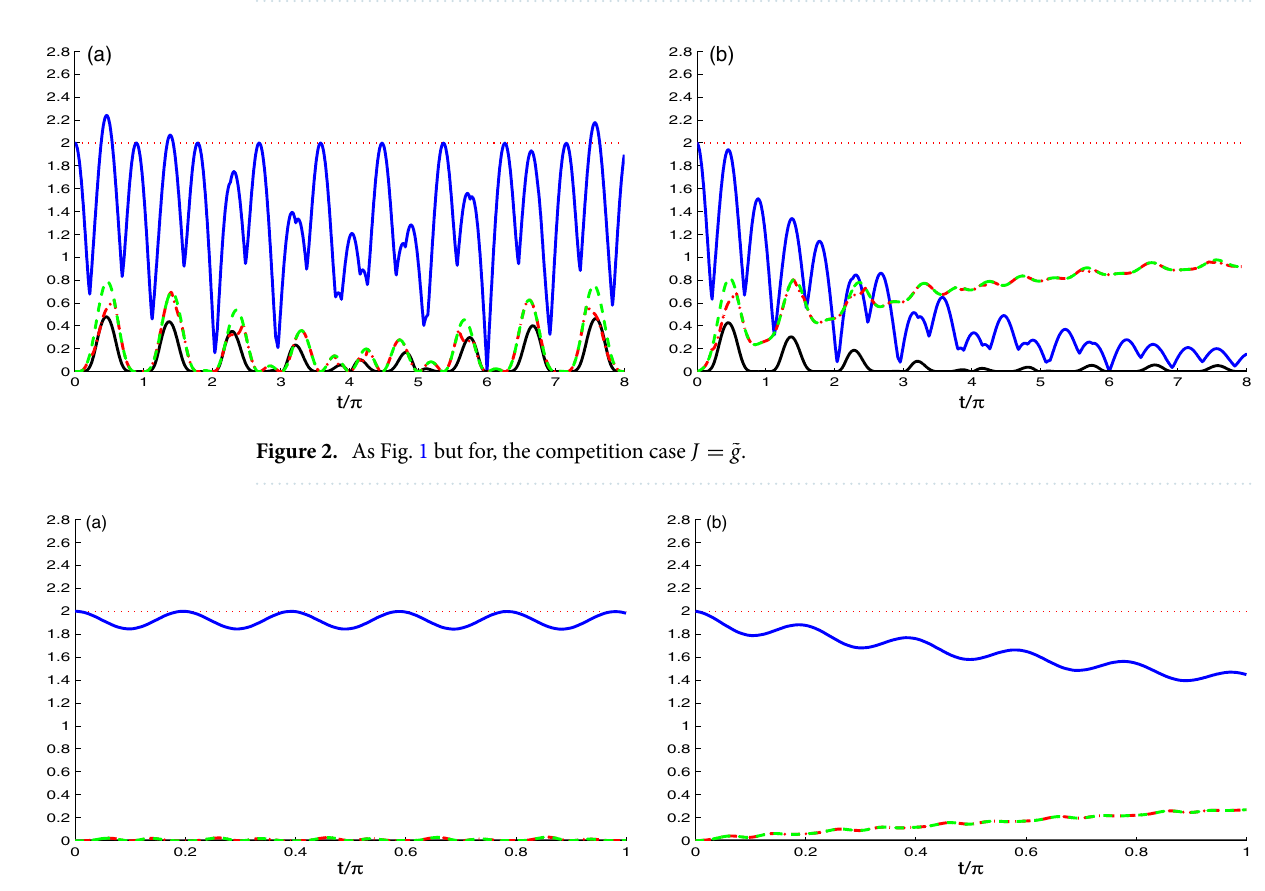
Figure 3. As Fig. 1 but for the case of the nancavities hopping coupling J greater than the N-V centers strength 10 g , where J g coupling ˜ = ˜